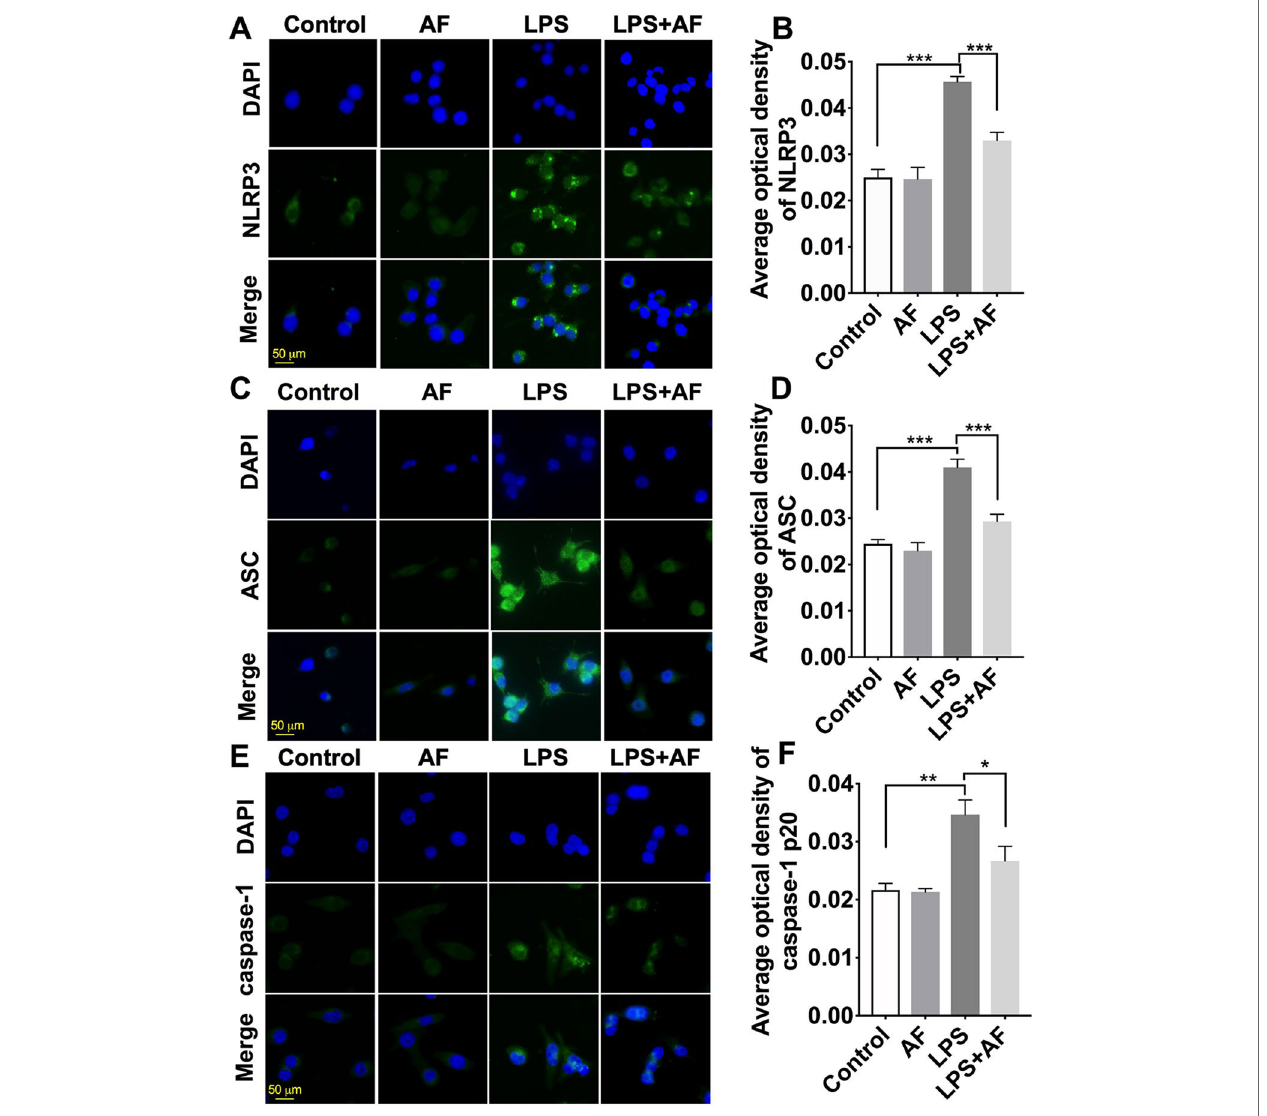
FIGURE 7 | Effects of amentoflavone on the expression of NLRP3 inflammasome activated by LPS in BV2 microglial cells. (A , C , and E ) Representative images of immunofluorescence staining of NLRP3, ASC, and caspase-1 in BV2 microglial cells. (B , D , and F) Semi-quantitative analysis of the relative levels of NLRP3, ASC, and caspase-1 by densitometric analysis ( Student’s t test ). Error bars represent mean ± s.d. *, **, *** represent p < 0.05, p < 0.01, p < 0.001, respectively. All experiments were performed in triplicate. LPS, lipopolysaccharide; AF,